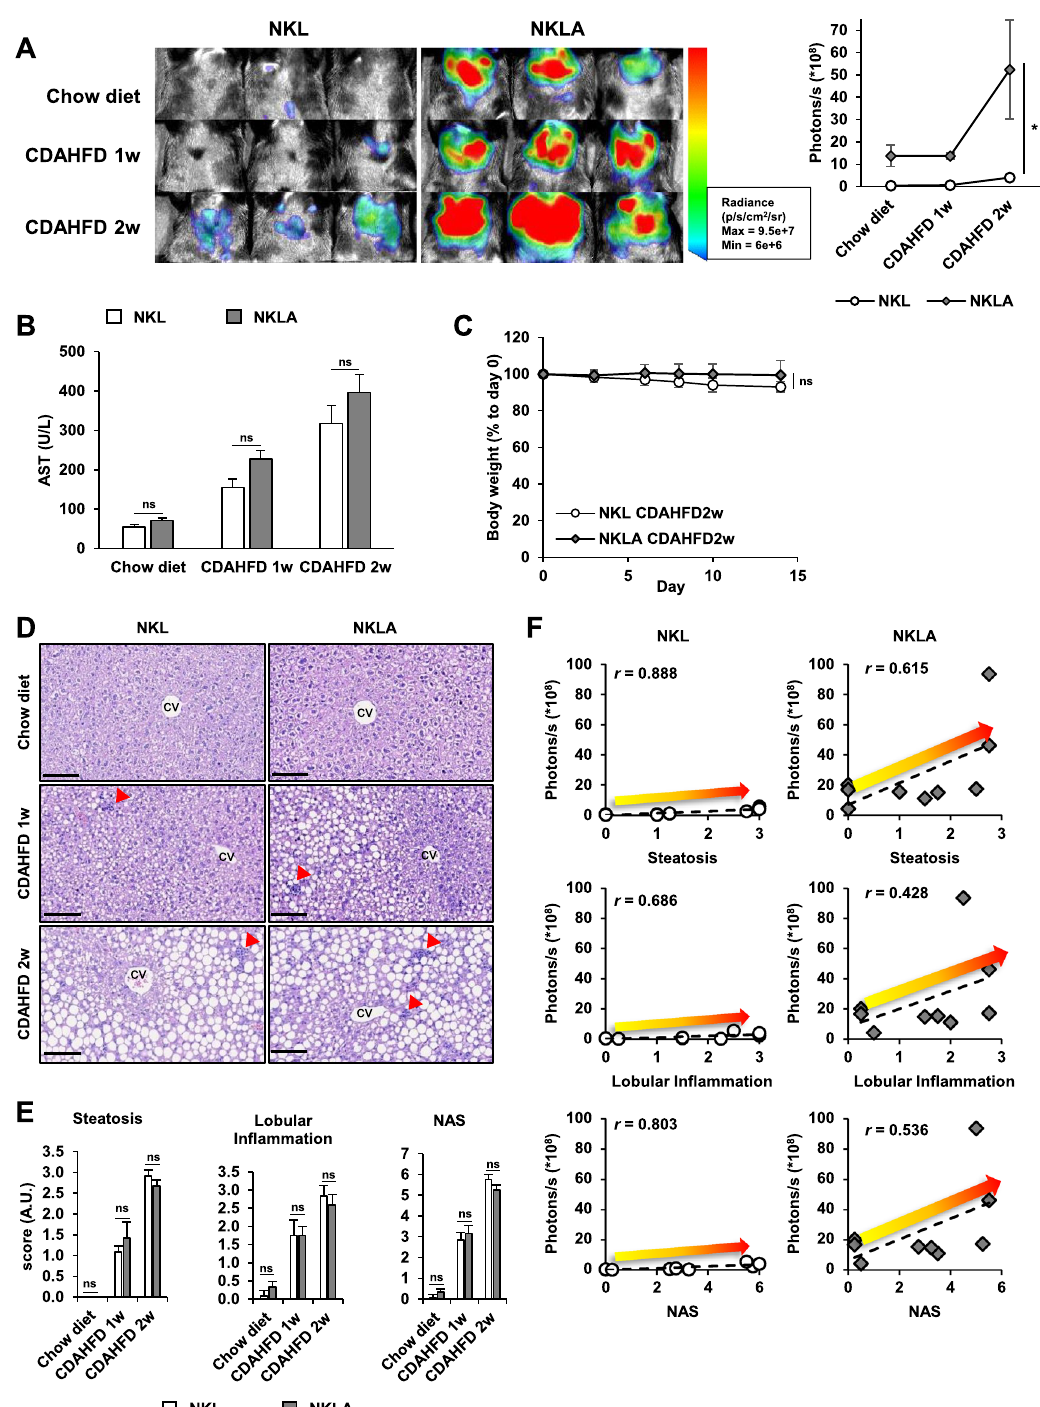
Figure 5. Non-invasive monitoring of inflammatory signals in the NASH model. NF-κB-Luc (NKL) and NF-κB-Luc:Alb (NKLA) mice were fed normal chow diet for 2 weeks or choline-deficient, L-amino acid- defined, high-fat diet (CDAHFD) for 1 or 2 weeks. (n = 3 per group) ( A ) Bioluminescence images of Chow diet group, CDAHFD 1w group, and CDAHFD 2w group for both genotype. The images were obtained at the end of experiments, and the bioluminescence intensities were represented as a graph. The experimental schedule is described in detail in Materials and Methods. ( B ) Serum aspartate aminotransferase (AST) levels and ( C ) body weight changes of NKL and NKLA mice. ( D ) Representative HE images of livers obtained from each group of NKL and NKLA mice (scale bar = 100 μm), and ( E ) histopathological scores. cv; central vein, arrowhead; inflammatory foci. ( F ) Correlations between histopathological scores and luminescence intensities. Correlation coefficients ( r ) are shown in the graphs. ns not